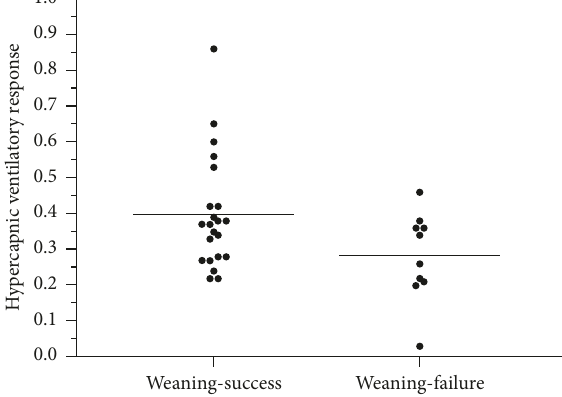
Figure 2: Plotted graph with hypercapnic ventilatory response of weaning-success and weaning-failure groups; 𝑃 = .036